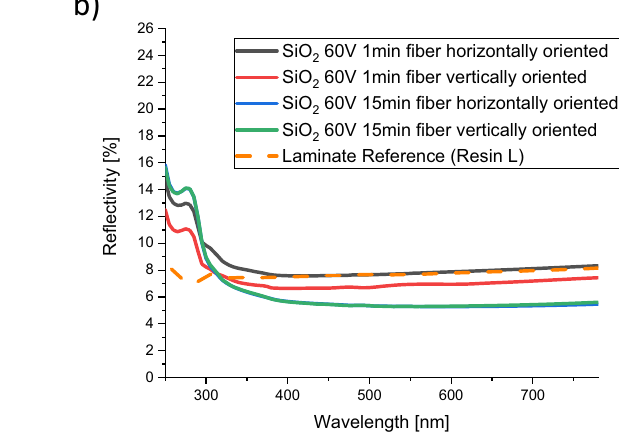
Figure 10: SiO 2 fi ber modi fi cation via EPD ( a ) before and ( b ) after the lamination process.